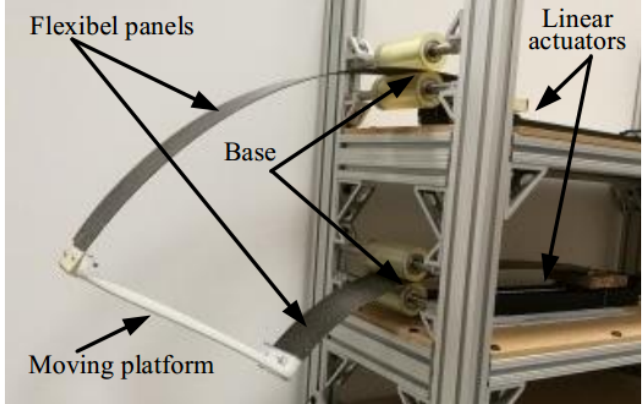
Figure 1. Structure of the flexible panel continuum robot. Due to this directionality, they are naturally constrained only to deform along the length direction, i.e., in the X–Z plane, as shown in Figure 2. Thus, the two panels along with the base and the moving platform form a planar flexible panel continuum robot. As the two linear actuators move back and forth, the panel lengths change to cause the robot to curve up or down, depending on the direction of the length difference between the two